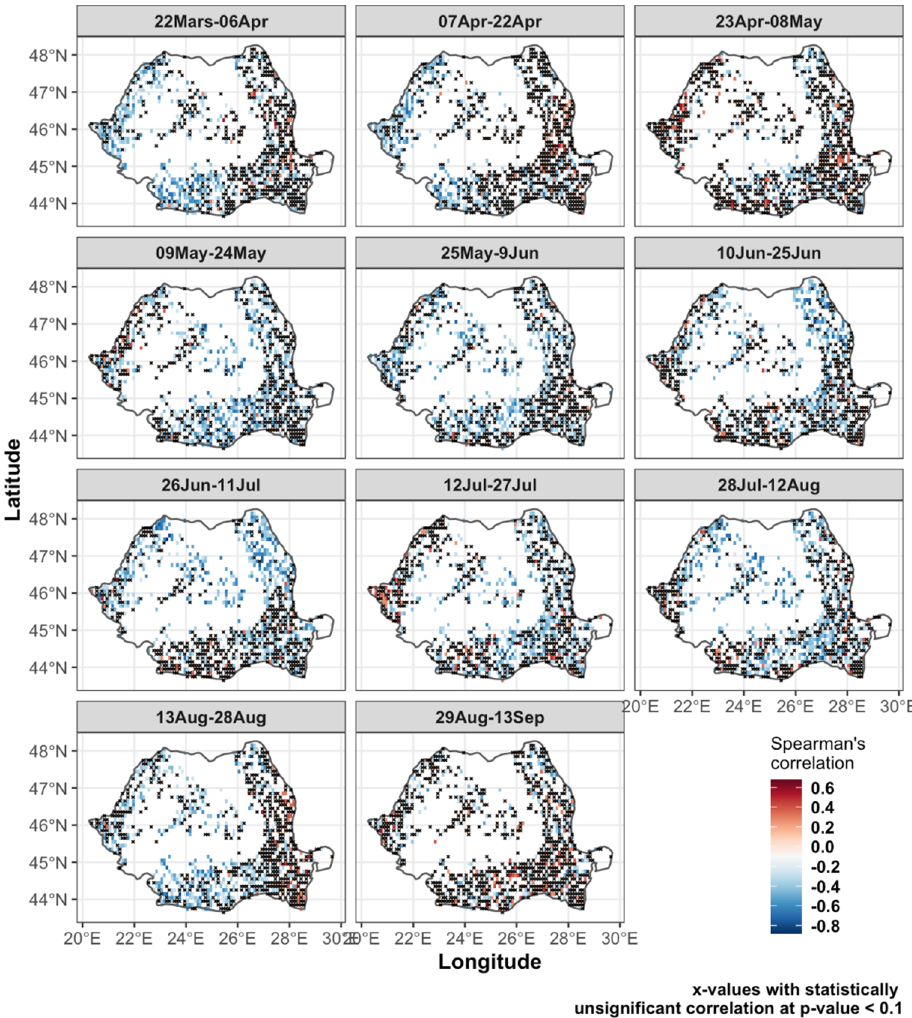
Figure 10. Spearman correlation between precipitation amount and the 1-composite lag of the NDDI.